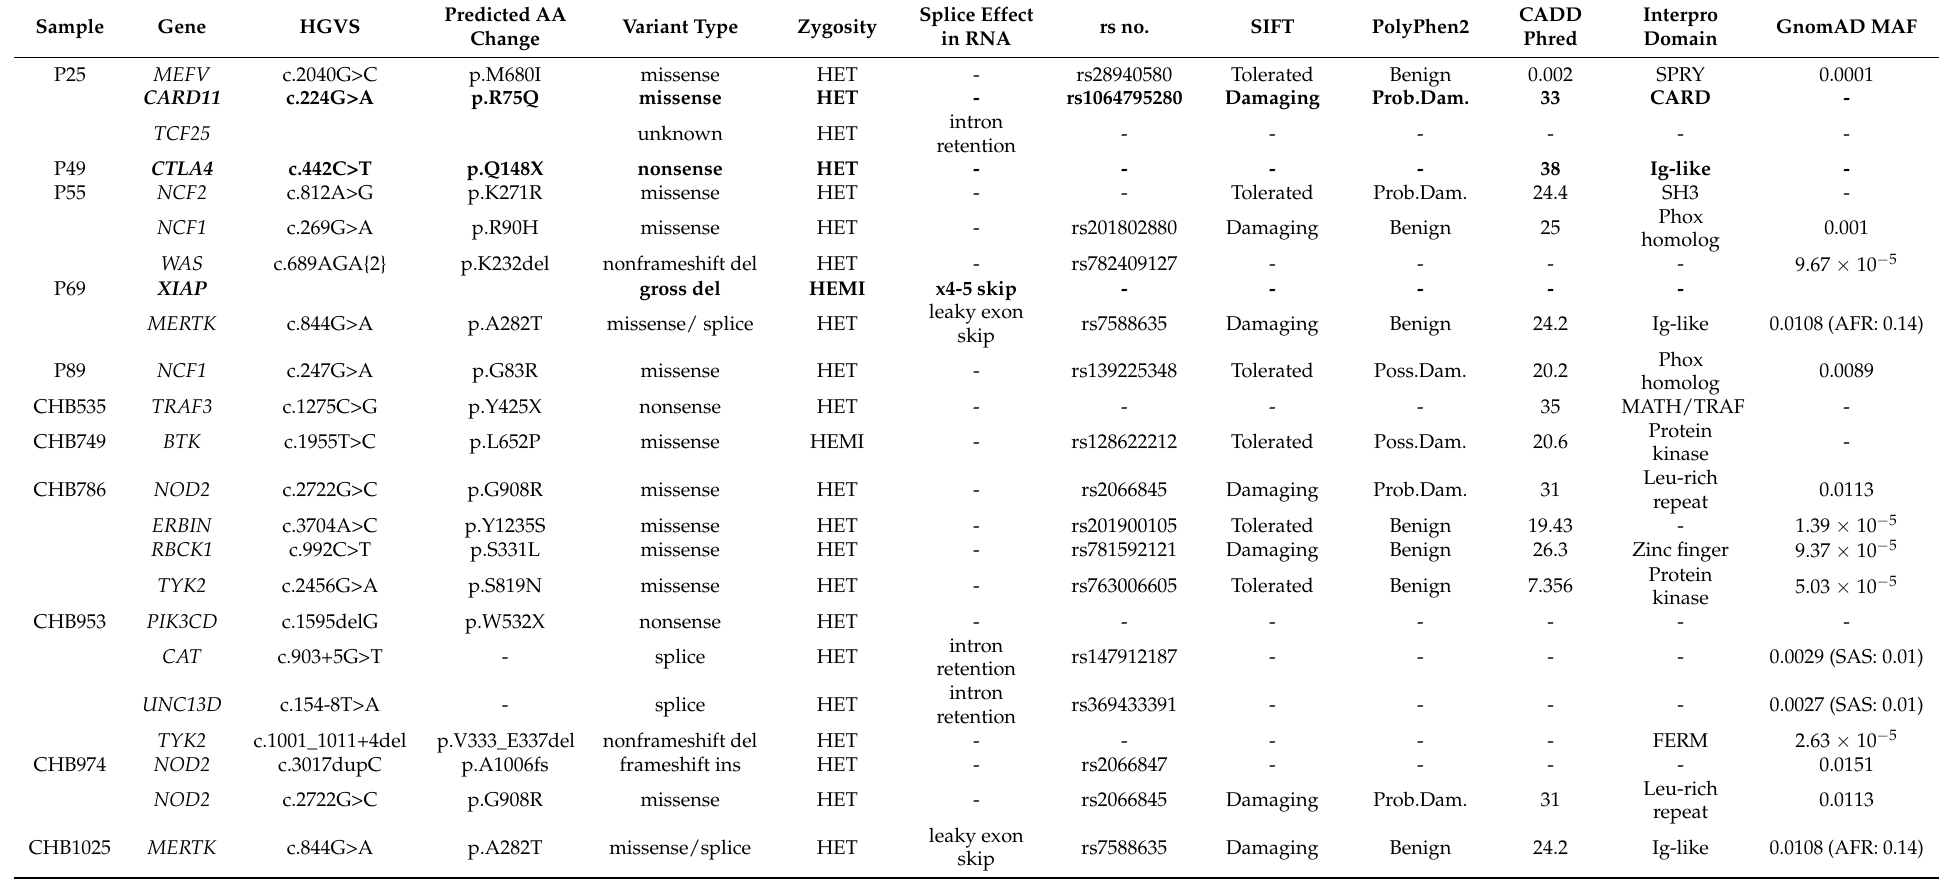
Table 1. Variants and splicing events of